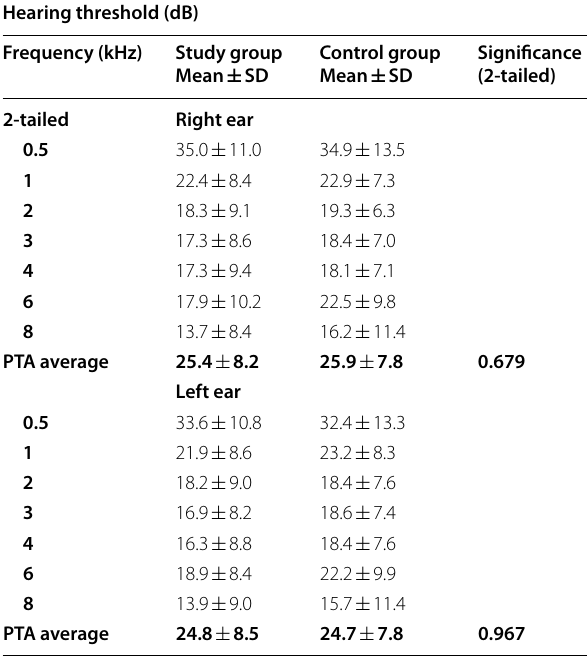
Table 3 Comparison of the pre-shift hearing thresholds of study subjects with the hearing thresholds of the control subjects Hearing threshold (dB)